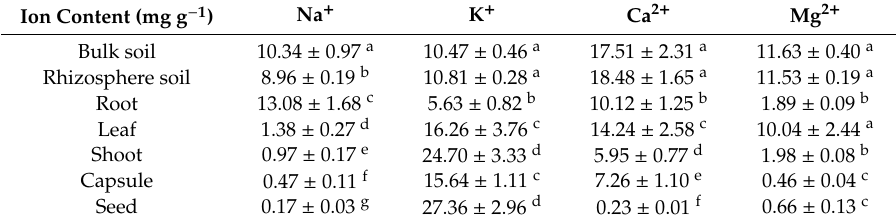
Table 2. Comparison of biomass and seed yield of wild soybean under artificial facilities and wild conditions. Cultivation Mode